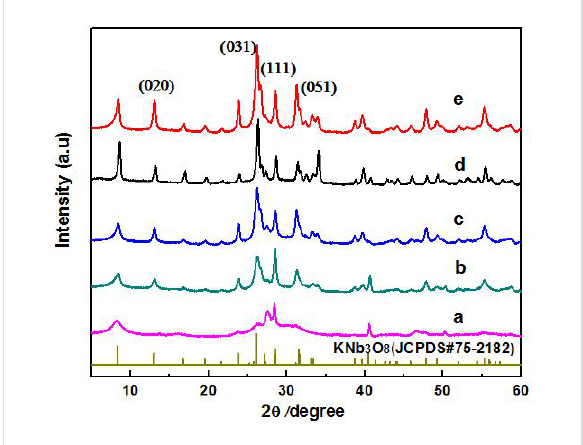
Figure 1: X-ray diffraction patterns of samples prepared at different KOH concentrations: (a) 0.5 M; (b) 1.0 M; (c) 2.0 M; (d) 3.0 M; (e) 4.0 M.